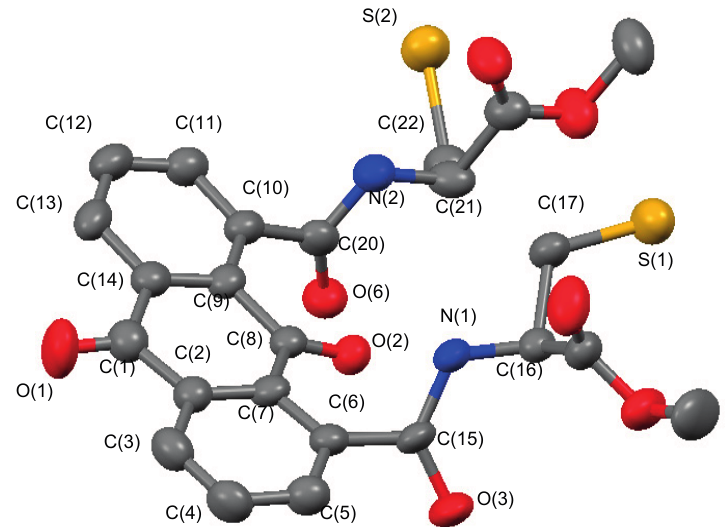
Figure 1. ORTEP drawing of 7 with ellipsoids at 50% probability. Hydrogen atoms are omitted for clarity. Blue, red, yellow, and black atoms indicate N, O, S, and C, respectively.